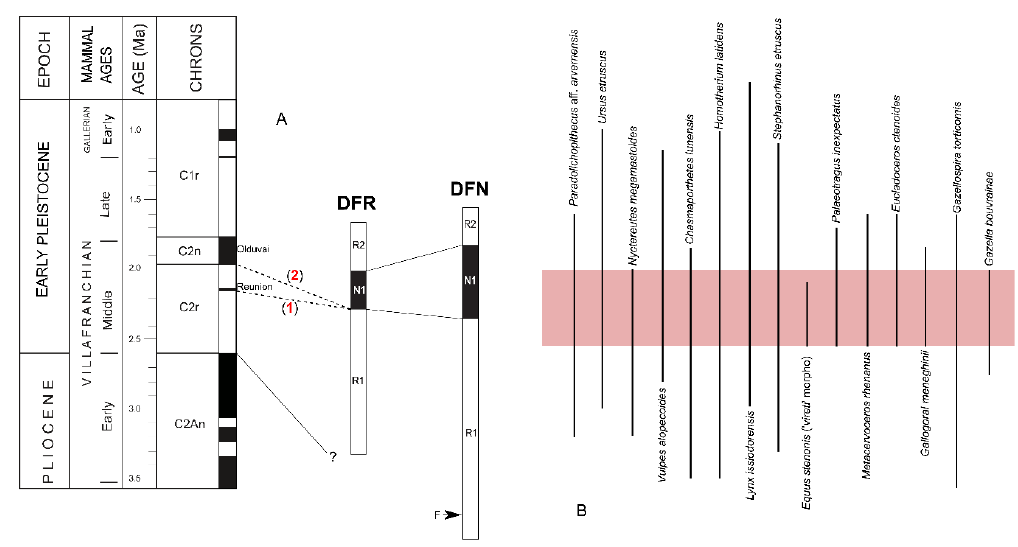
Figure 7. Chronology of Dafnero fossil sites. ( A ) Magnetostratigraphic correlation among the Dafnero sections, and GPTS [52]; two alternative scenarios are given (1): correlation of N1 zone with the Réunion subchron, and (2): correlation of N1 zone with the Olduvai subchron (for discussion see text). ( B ) Biochronological frame (reddish bar) provided by Dafnero mammal association; vertical lines represent the known time-range of 15 out of 19 mammal taxa recorded at Dafnero.